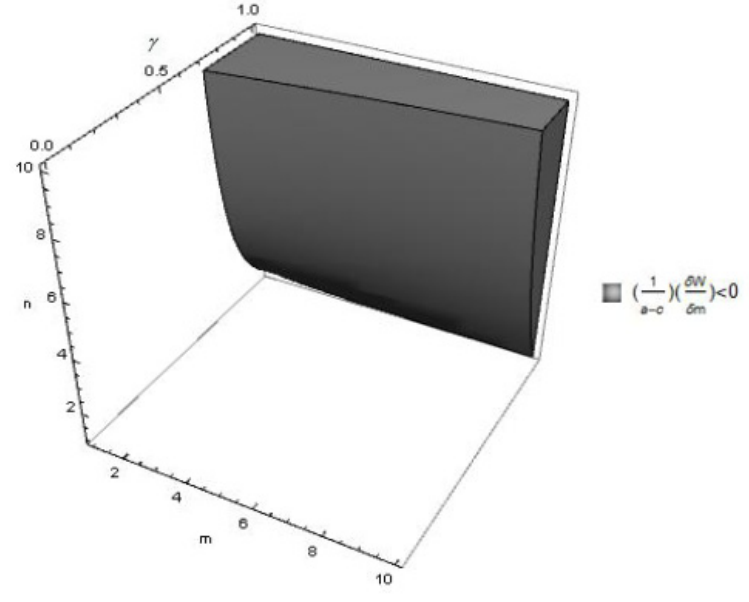
(cid:3105)(cid:3024) Figure 4. (cid:2869) for 𝑛 ∈ [1,10] , 𝑚 ∈ [1,10] and 𝛾 ∈ [0,1] . (a-c) (cid:3105)(cid:3040) The shaded (white) region in Figure 4 shows 1 The shaded (white) region in Figure 4 shows